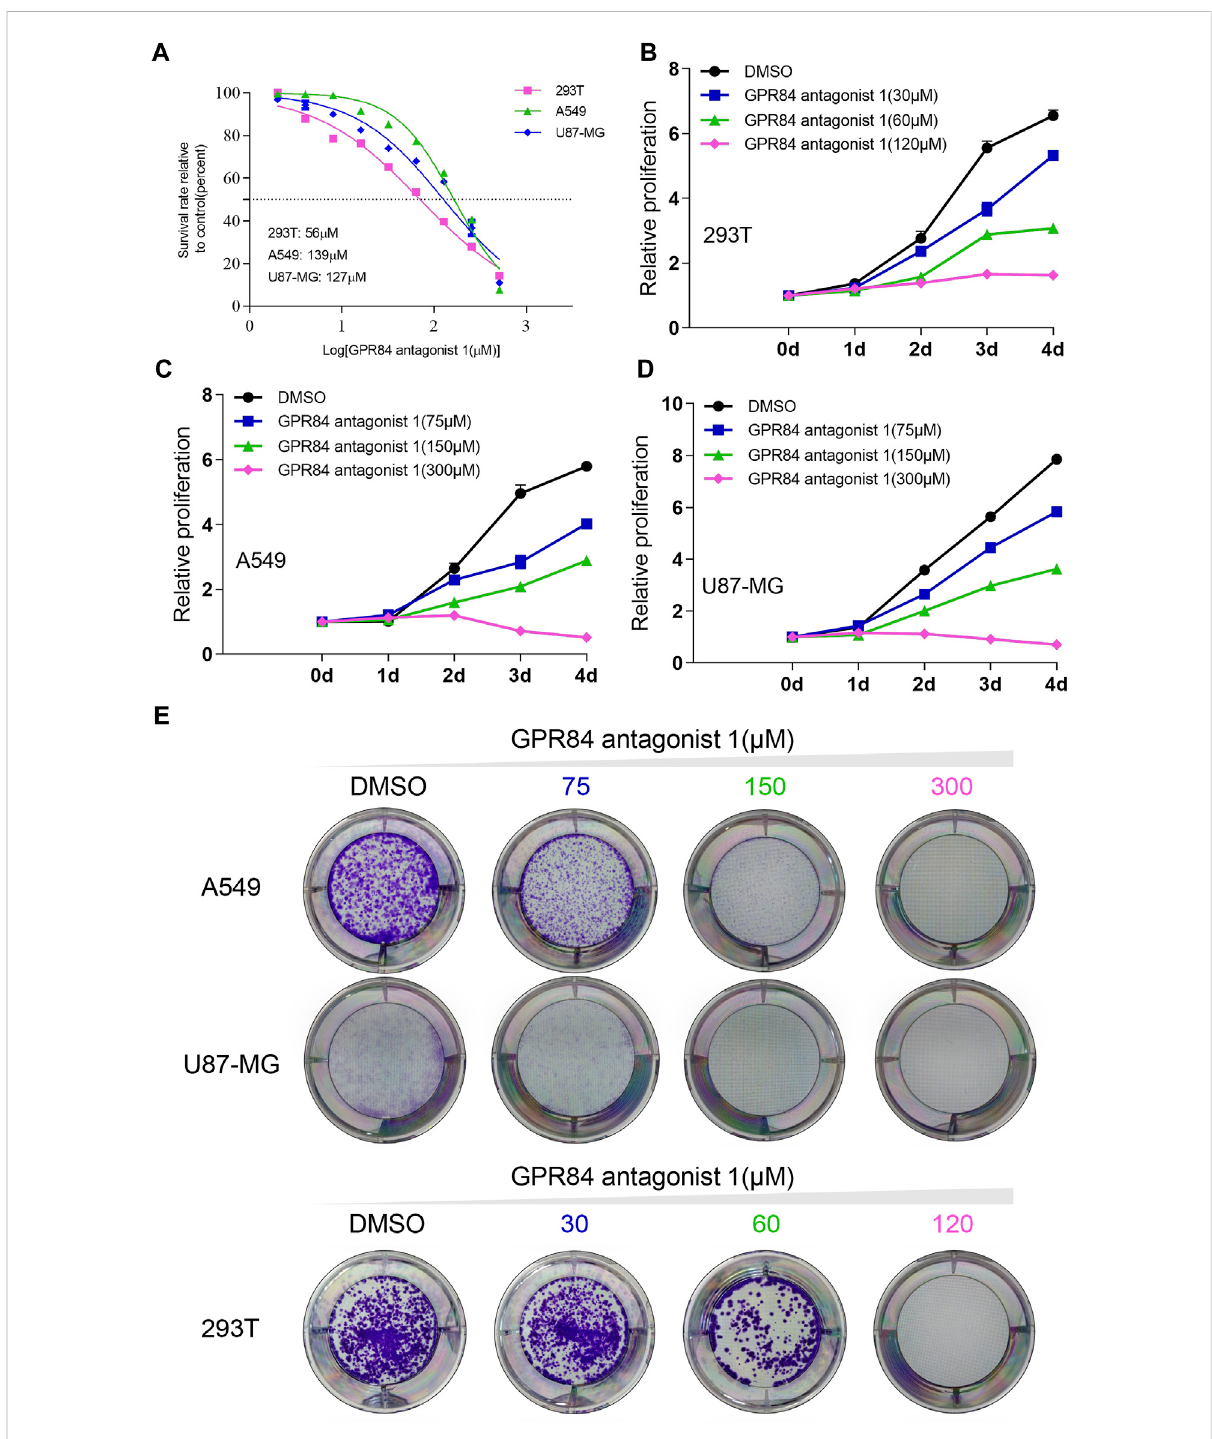
FIGURE 6 Blocking GPR84 reduced the proliferation of cancer cells. (A) IC50 curve of GPR84 antagonist one in A549, U87-MG and 293T cells. Cell proliferation of 293T (B) , A549 (C) and U87-MG (D) cells treated with GPR84 antagonist one or DMSO was tested by a cell viability assay. (E) The